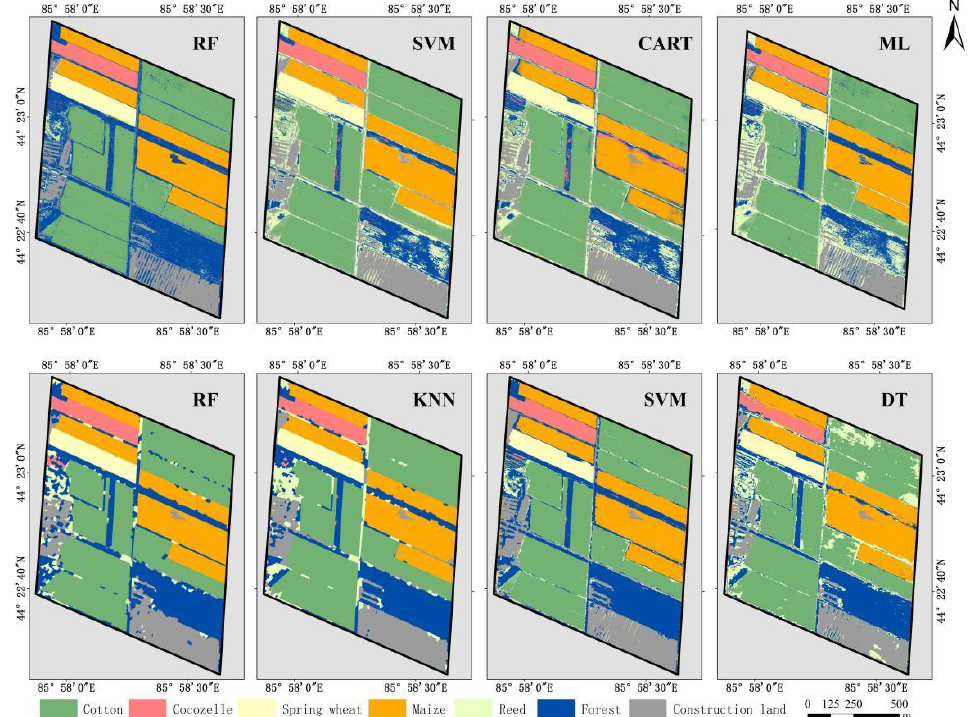
Figure 9. Crop classification results of different classification methods based on time-series remote sensing images. Note: The first line is the result based on pixel classification, and the second line is the result based on object-oriented classification.